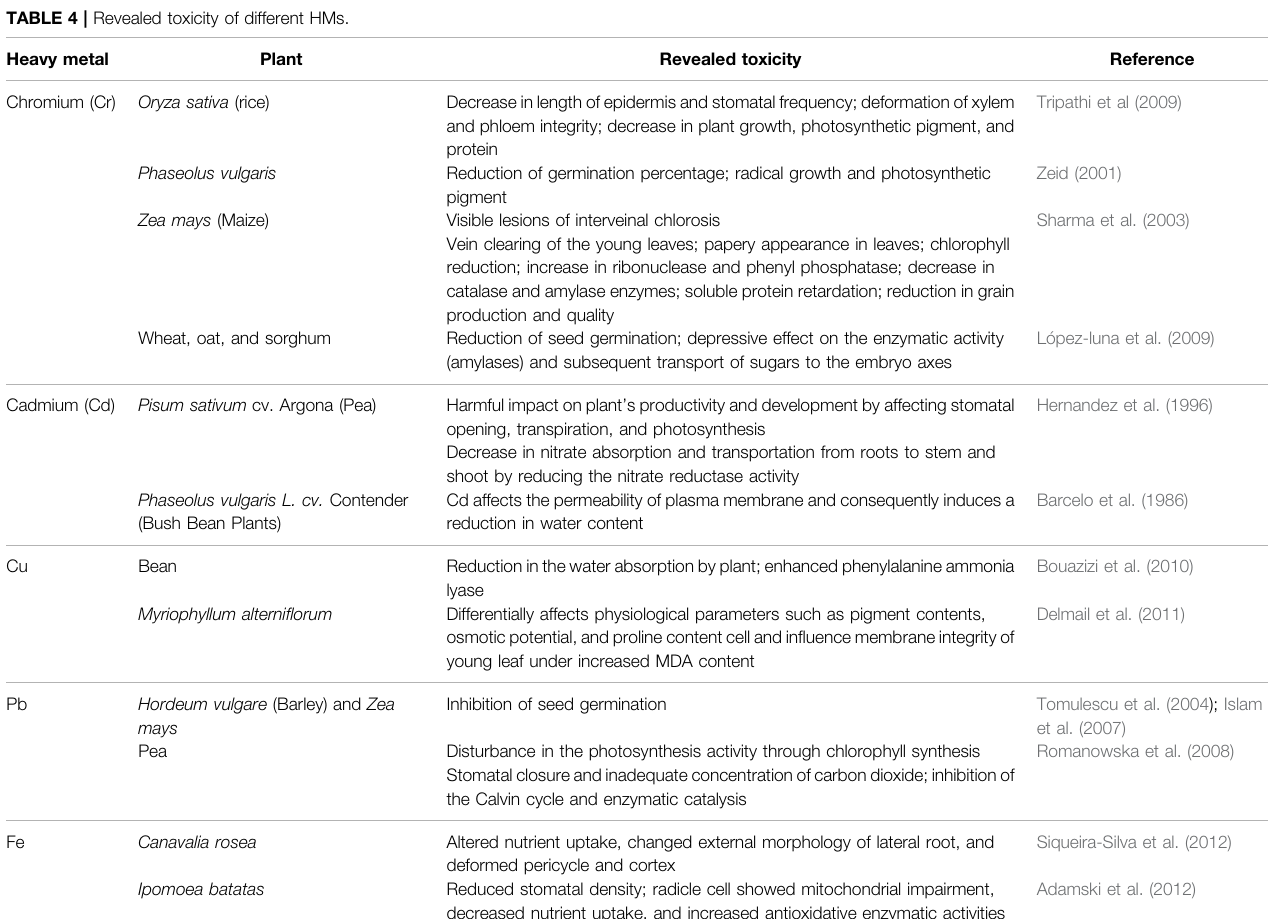
TABLE 4 | Revealed toxicity of different